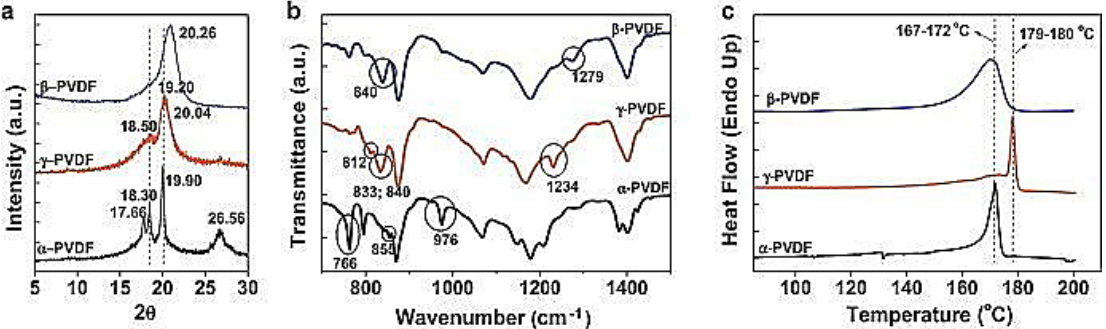
Figure 2. Synopsis of main experimental features of the different experimental techniques for correct identification of the PVDF phase: ( a ) XRD (K α1 ,γ = 1.5405600 Å); ( b ) FTIR; and ( c ) DSC [16].